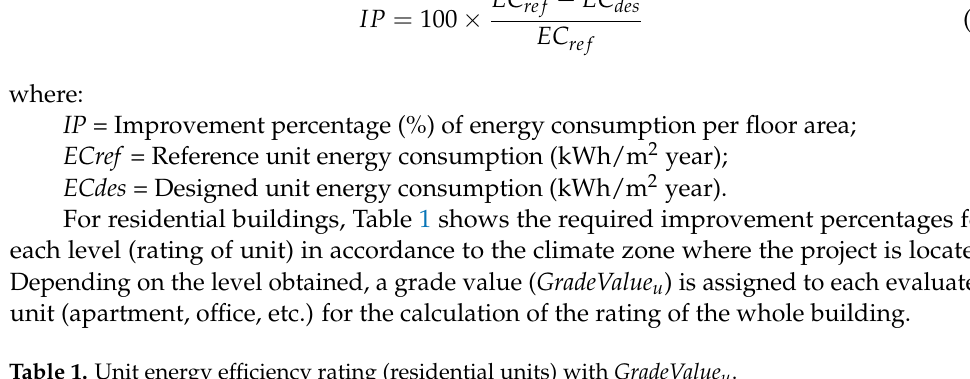
Table 1. Unit energy efficiency rating (residential units) with GradeValue u